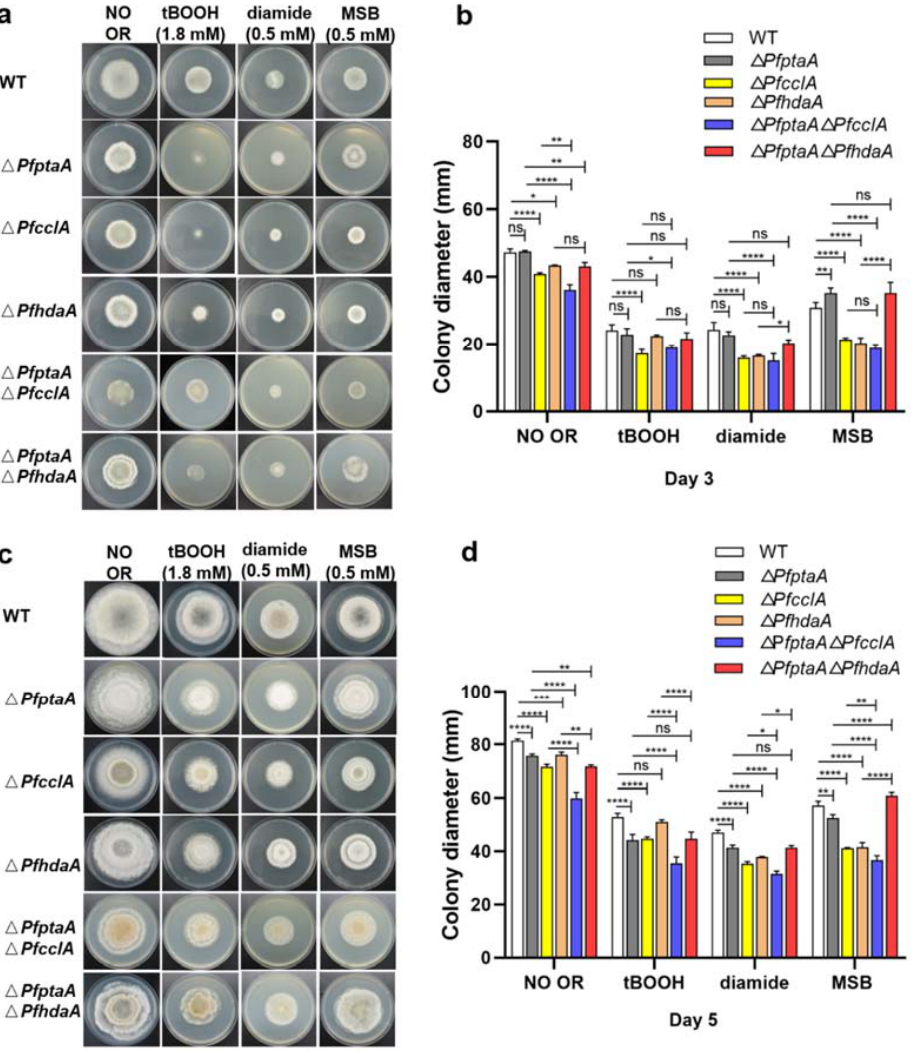
Figure 5. Comparison of oxidative stress tolerances of P. fici strains. ( a ) Mycelia growth of the mutants under oxidative stress on the 3rd day; ( b ) the colony diameters of the testing strains were measured on the 3rd day; ( c ) mycelia growth of the mutants under oxidative stress on the 5th day; ( d ) the colony diameters of the testing strains were measured on the 5th day. The spores of WT strain and mutants were inoculated on PDA media with or without tBOOH (1.8 mM), diamide (0.5 mM), or MSB (0.5 mM), and cultured at 25 ℃ for 5 days. Three replicates were done for each culture of strain. OR is the abbreviation of oxidative reagents. Error bars represented the standard deviations. Asterisks indicate significant differences in mean values ( p < 0.0001 (****), p < 0.001 (***), p < 0.01 (**), p < 0.05 (*)).